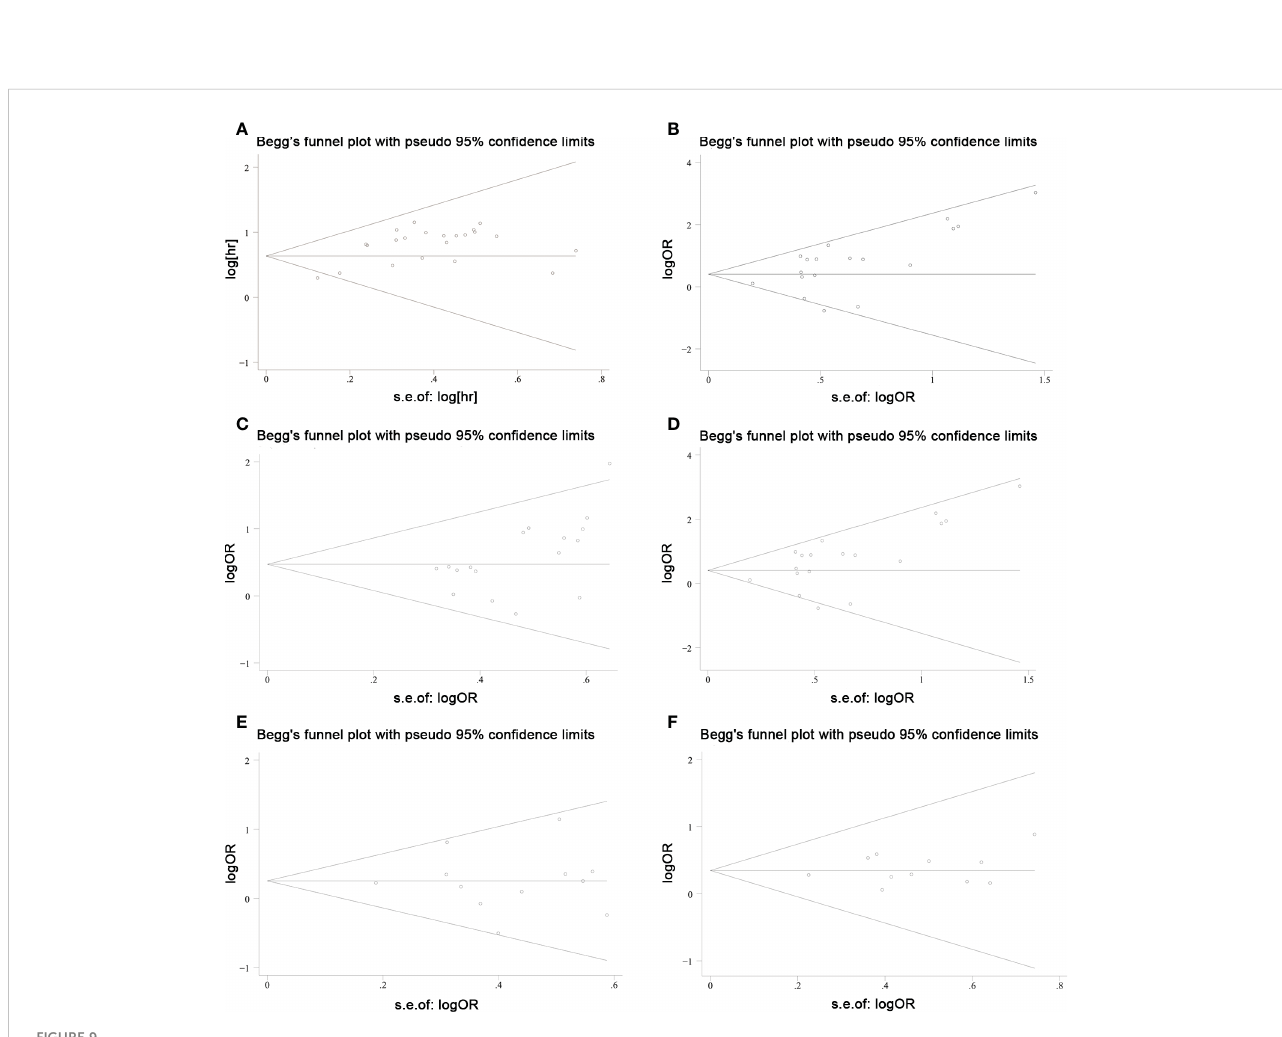
FIGURE 9 Publication bias was explored using Begg ’ s test in colorectal cancers. (A) overall survival; (B) TNM stage; (C) lymph node metastasis; (D) distant metastasis; (E) tumor size; and (F) histological